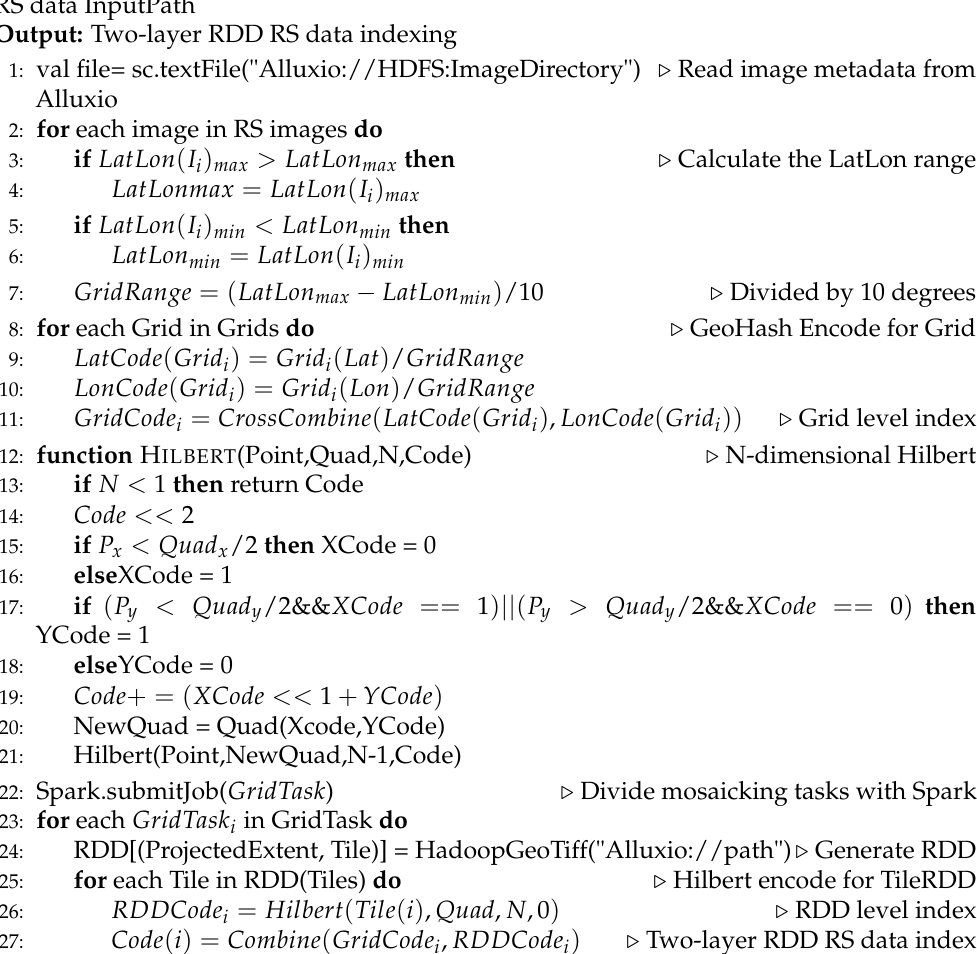
Algorithm 1 Two-layer RDD RS data indexing construction in in-memory distributed large-scale